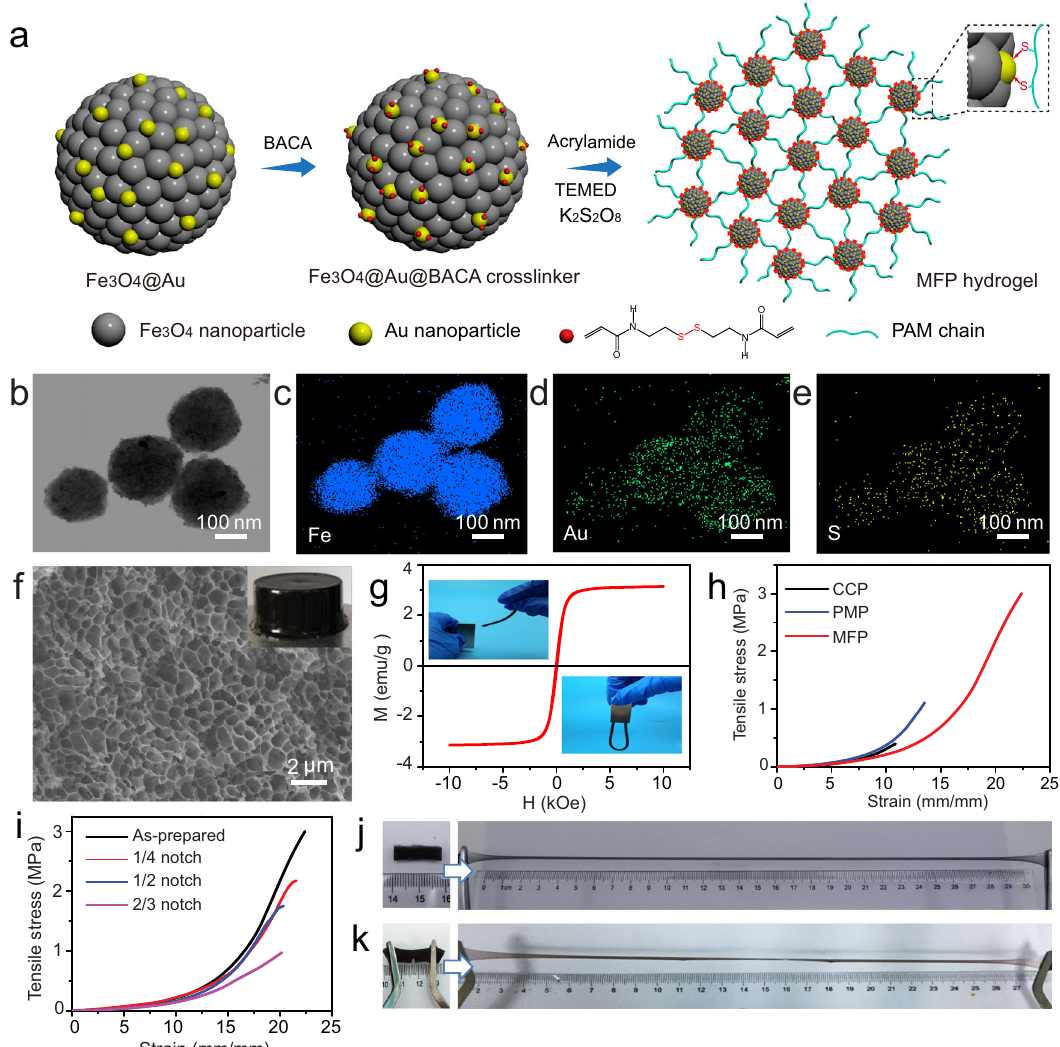
Fig. 1 Preparation and characterization of MFP hydrogel. a Schematic illustrations of the preparation of MFP hydrogel. b TEM image of Fe 3 O 4 @Au@BACA composites. c – e Corresponding element mappings of Fe, Au, and S, suggesting the ultra fi ne coating of BACA. f SEM image of MFP hydrogel. The inserted photograph shows a columnar hydrogel. g Magnetic hysteresis loops of MFP hydrogel. The inserted optical images show magnetic response of MFP hydrogel with a magnet. h Tensile stress – strain curves of CCP, PMP, and MFP hydrogels. i Tensile stress – strain curves of MFP hydrogel notched with different sizes. Optical images show high stretchability of ( j ) MFP hydrogel and ( k ) the notched MFP